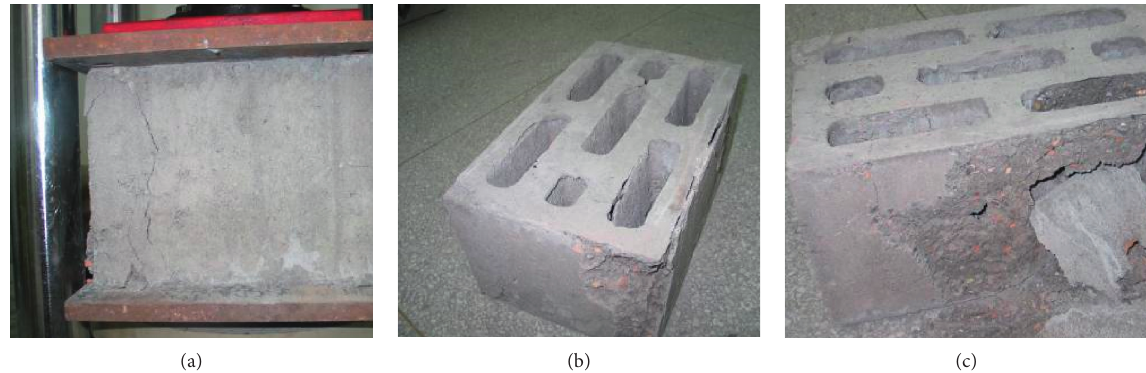
Figure 4: Failure process of specimens. (a) Cracks on surface; (b) failure on edge; (c) final